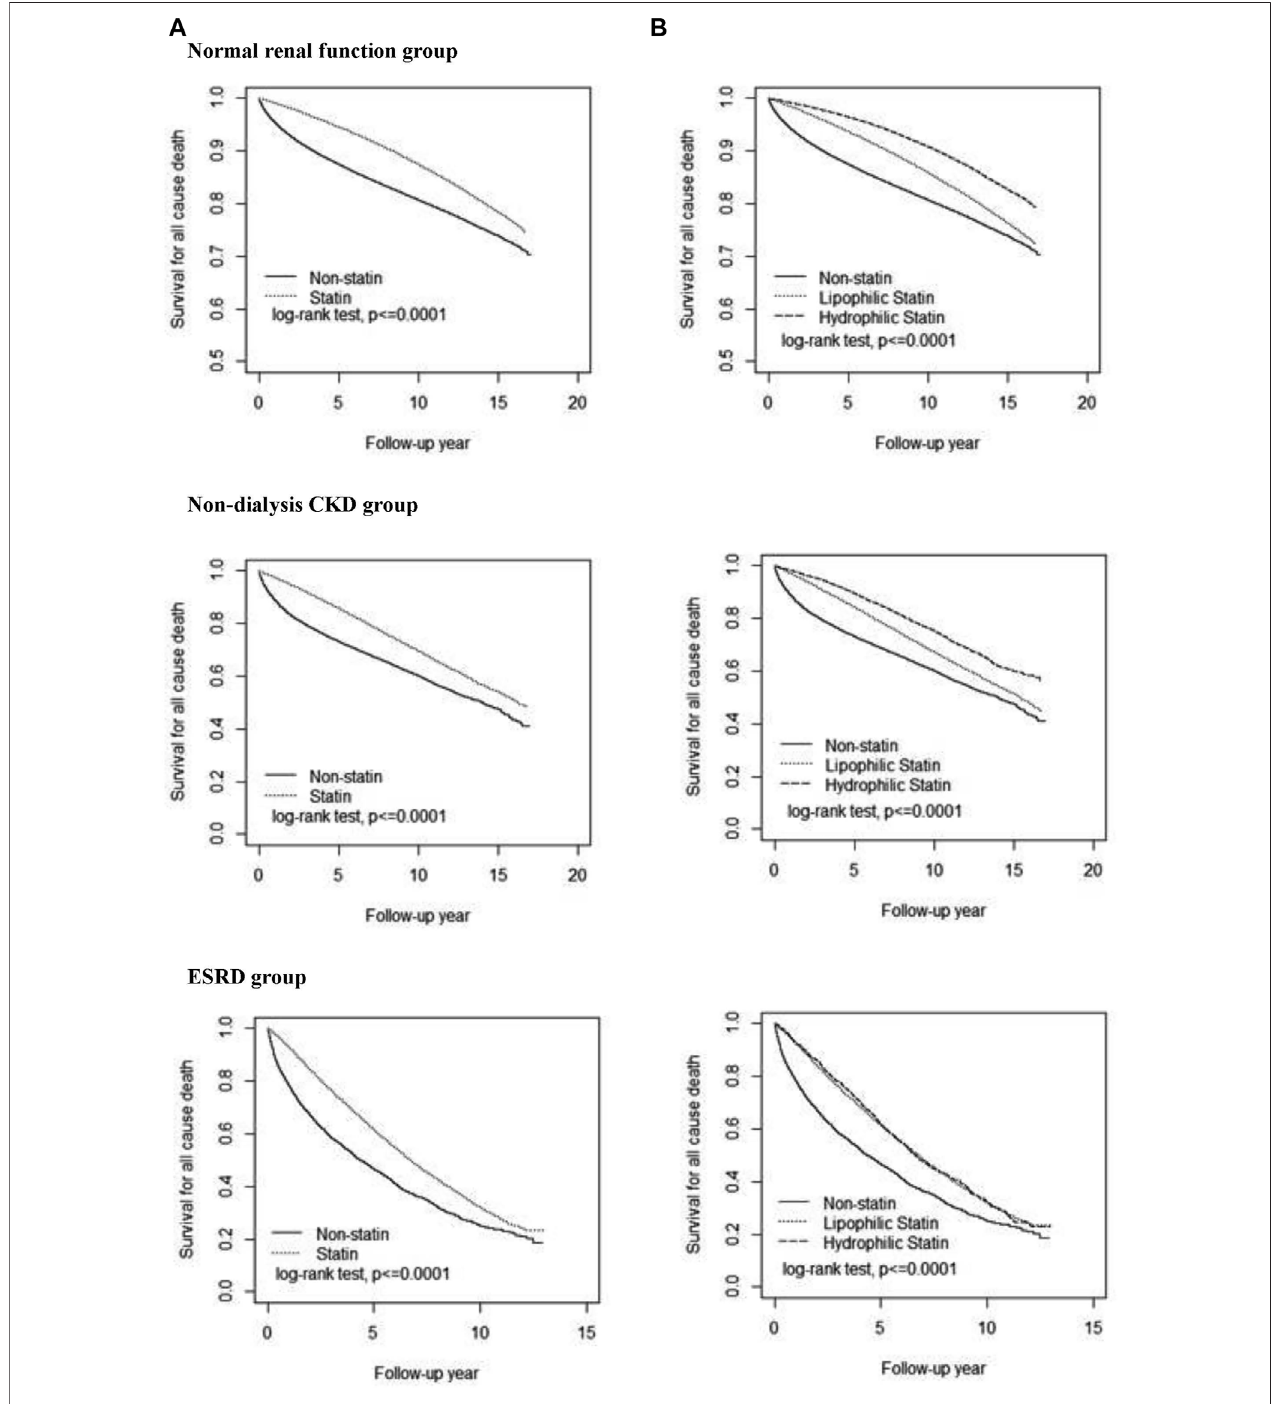
FIGURE.2| Cumulativesurvivalprobabilityamongthreerenalgroups. Comparisons ofall-causedeathinpatients withstatin therapyversusnon-statintherapy (A) and with hydrophilic statin versus lipophilic statin (B) . CKD, chronic kidney disease; ESRD, end-stage renal disease.